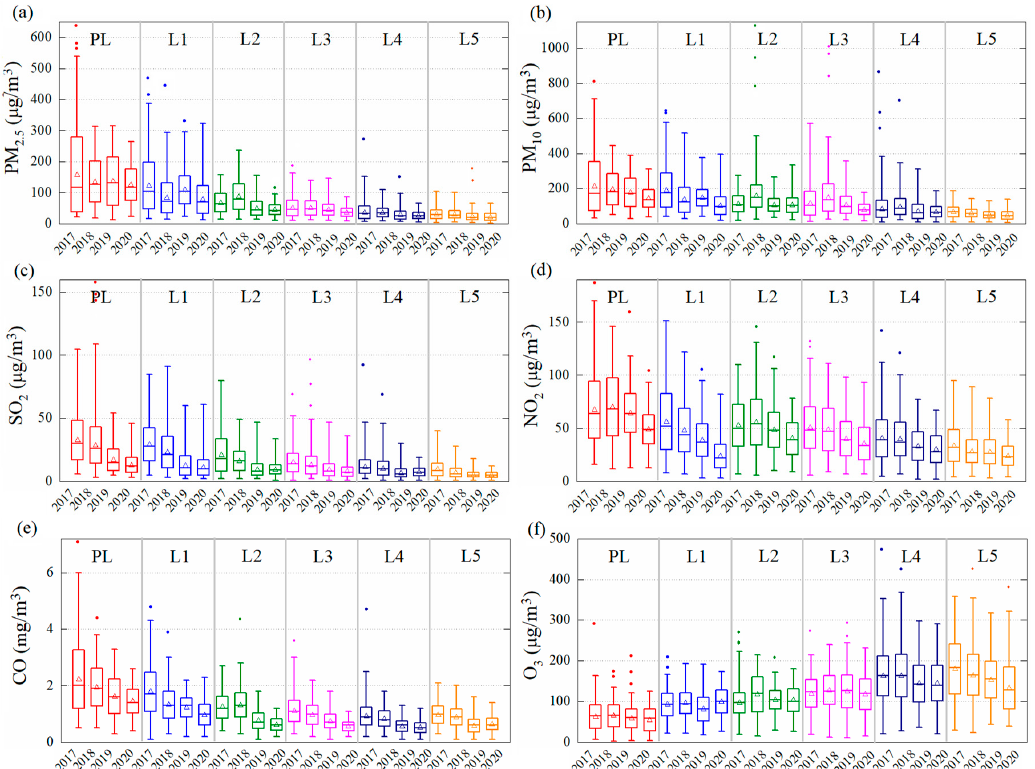
Figure 3. Box plots of the average particulate matter (PM) PM 2.5 ( a ), PM 10 ( b ), SO 2 ( c ), NO 2 ( d ), CO ( e ) and O 3 ( f ) concentrations averaged over all ground-based monitoring stations in the Guanzhong Basin, during each of the six stages (Pre-lockdown, PL; Level-1, L1; Level-2, L2; Level-3, L3; Level-4, L4; Level-5, L5), for each of the years between 2017–2020. The horizontal line and the triangle in each box present the median and mean values. The top and bottom of each box are the upper and lower quartiles and the lines connect the maximum and minimum values. The circles are outliers. Note the different vertical scales for each species.